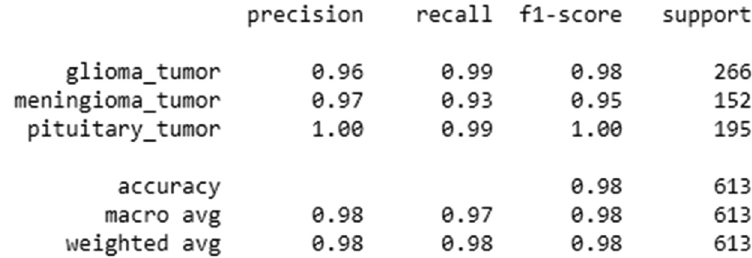
Figure 12: Classi fi cation report of